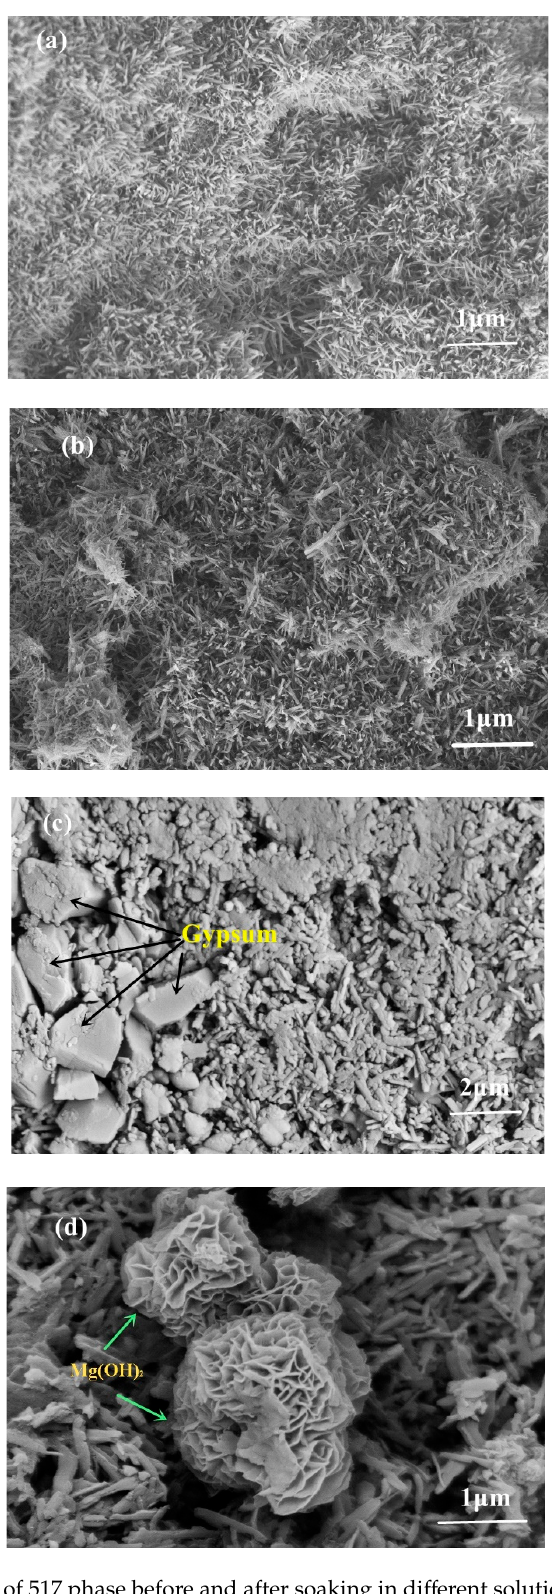
Figure 8. SEM images of 517 phase before and after soaking in different solutions: ( a ) before soaking; ( b ) after soaking in NaCl solution for 28 days; ( c , d ) after soaking in CaCl 2 solution for 28 days.